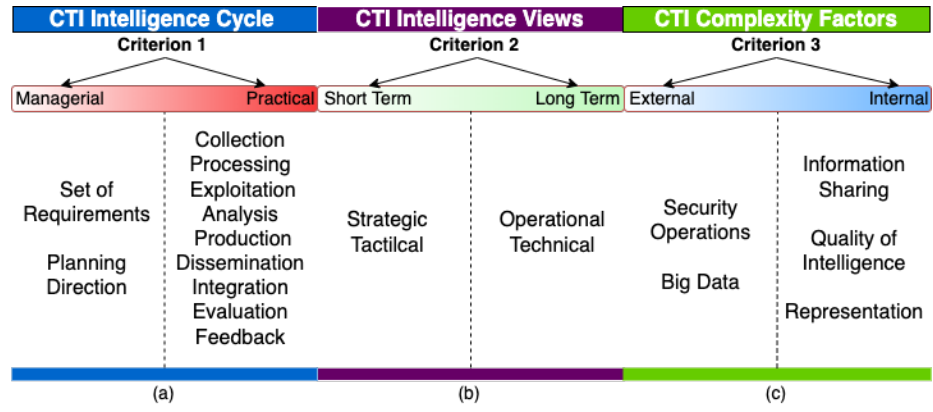
Figure 6. Applying: ( a ) Criterion 1, ( b ) Criterion 2, and ( c ) Criterion 3 to model elements.